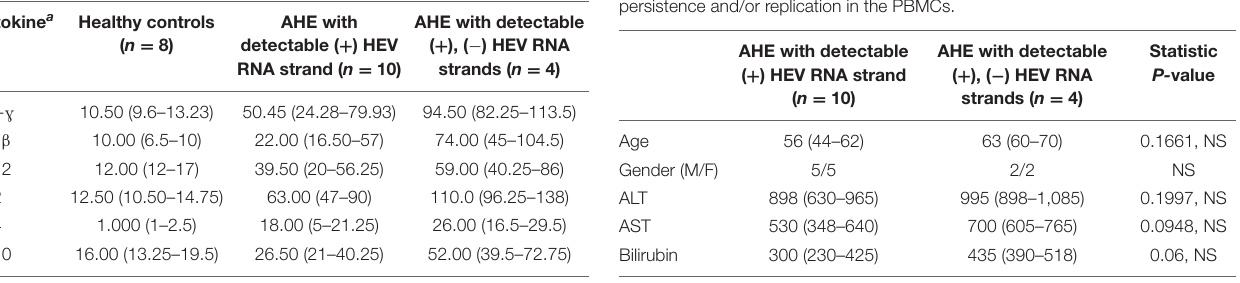
TABLE 2 | The level of cytokines in the plasma of AHE patients and healthy controls. TABLE 3 | Demographic and laboratory characterization of AHE Patients with viral